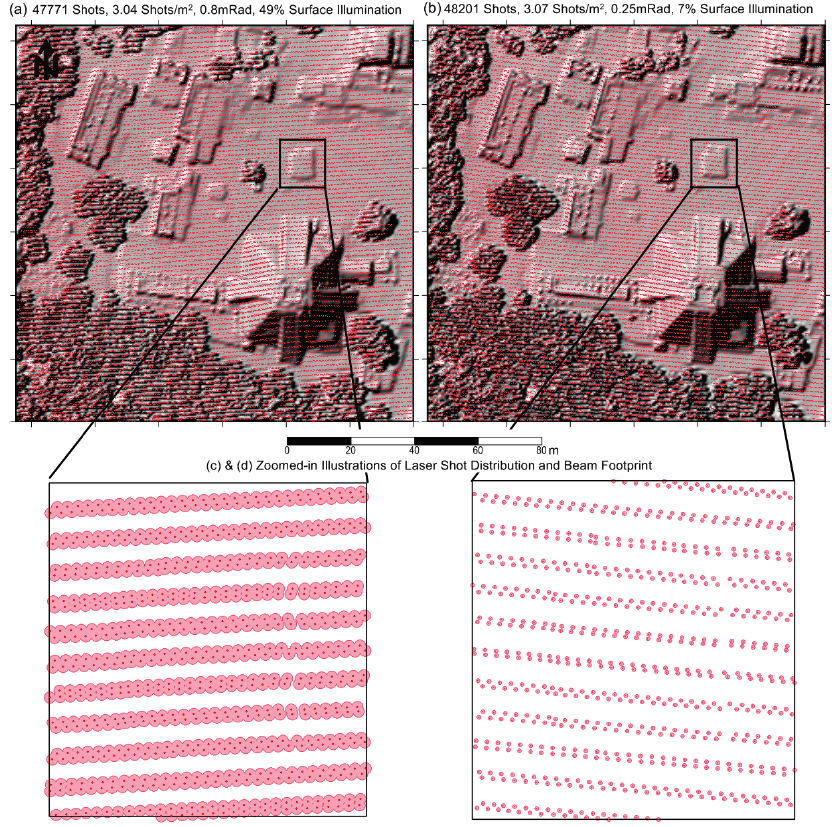
Figure 11. Comparison of laser shot density and fraction of surface illumination. Shaded relief images of DSMs produced from ALS data collected with a beam divergence of ( a ) 0.8 mrad and ( b ) 0.25 mrad, overlaid with the first LiDAR returns that were used to generate the DSMs. Parts ( c ) and ( d ) are zoomed-in illustrations of the laser shot distributions and their